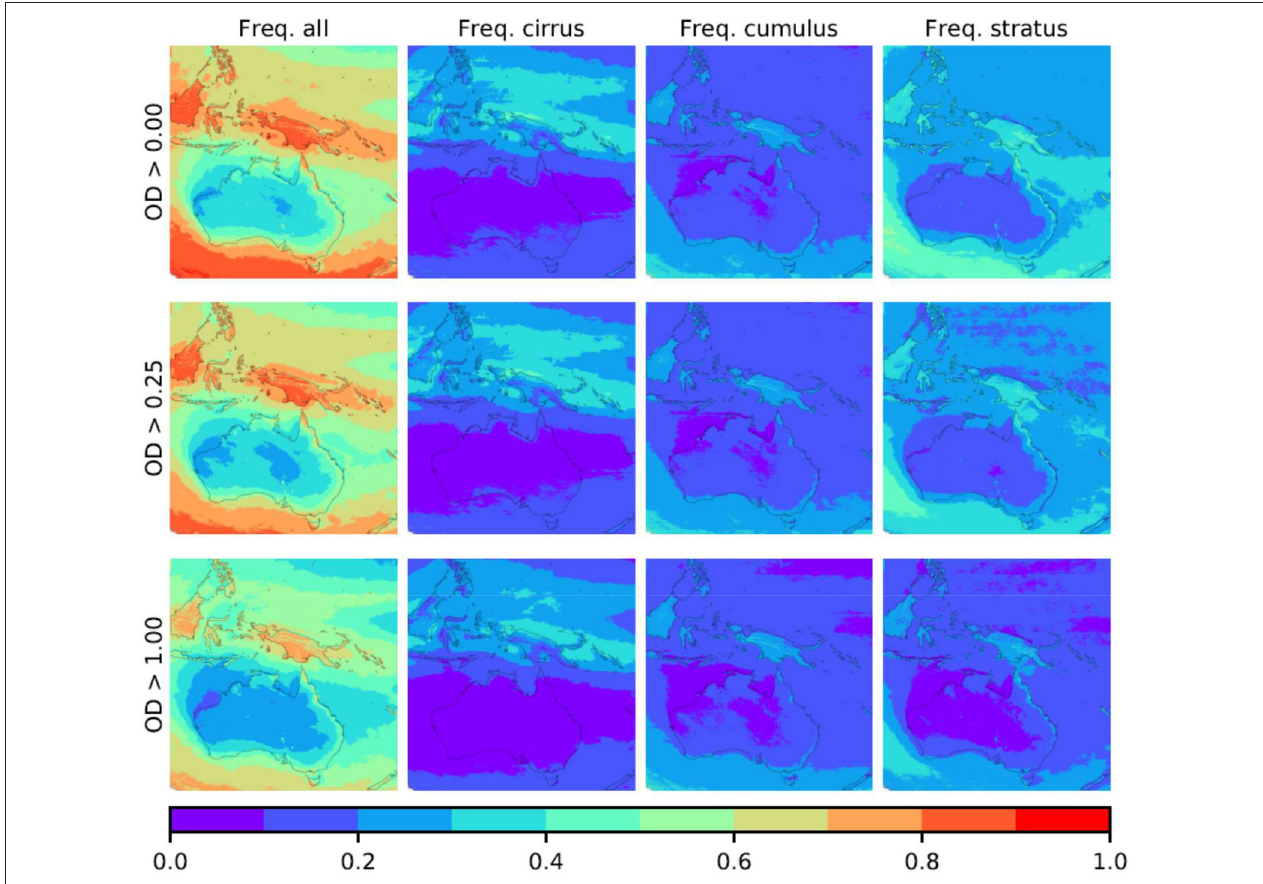
FIGURE 17 | Change of yearly mean cloud frequency with lower optical depth (OD) thresholds: the top row shows all data; the middle row only when OD > 0.25; and the bottom row when OD > 1.0. Data obtained for the period from 1 Jan 2016 to 30 Nov 2017 for daylight hours from 22UTC to 8UTC (8–18 Australian east standard